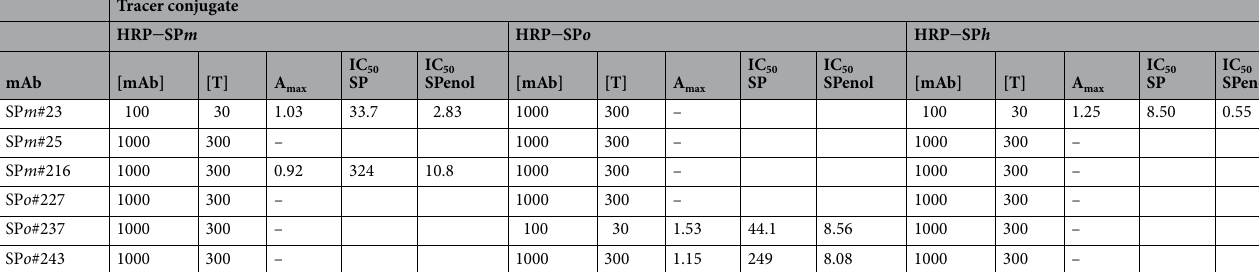
Table 1. Checkerboard assay using the capture antibody-coated direct cELISA (n = 3). [mAb], antibody concentration in μg/L; [T], tracer concentration in μg/L; IC 50 , values are expressed in nM units; –, signal was lower than